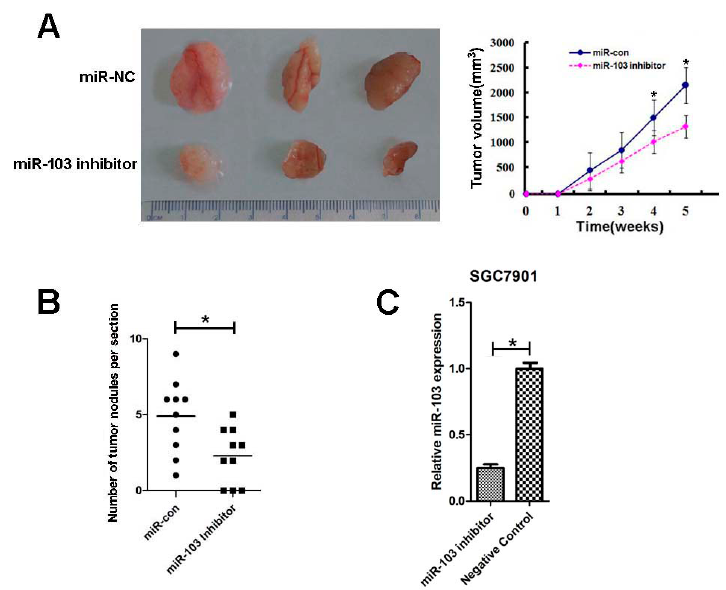
Figure 4. miR-103 promotes gastric cancer cell growth and metastasis in vivo. ( A ) Tumor volumes were measured on the indicated days; ( B ) The number of lung metastasis of indicated SCID mice groups and ( C ) RT-qPCR analysis of miR-103 expression in implanted tumors. * p < 0.05; the data represent the mean ± SD from triplicate measurements.